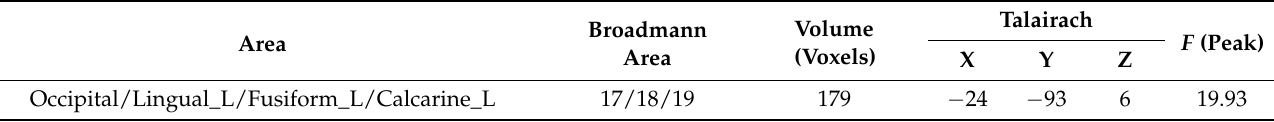
Figure 2. ReHo changes among the three time points: ( A ) Difference of ReHo maps among the three time points; ( B ) extracted clusters of significant ReHo alteration in three time points. *** p < 0.001. Table 4. Regional information of changed ReHo in repeat ANOVA.